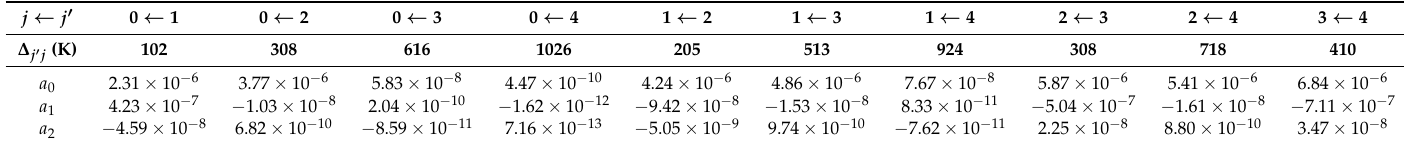
Table 9. Same as Table 7 for 3 HeH + .